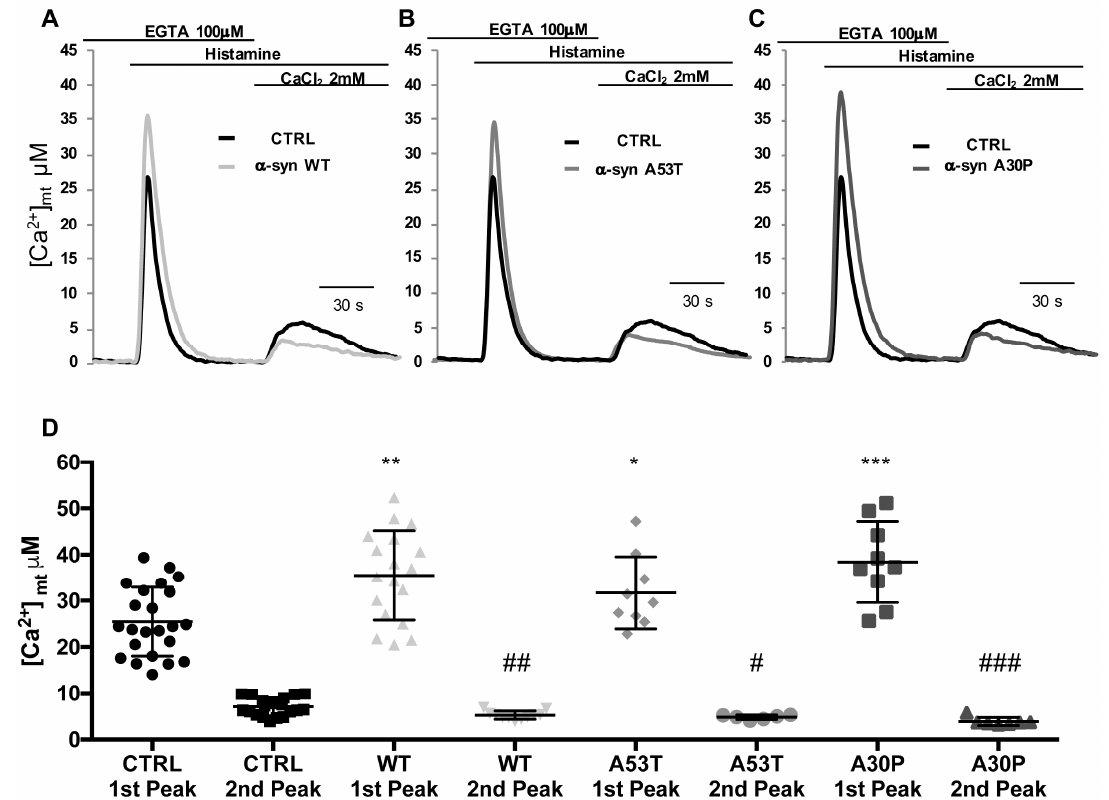
Figure 3. α -syn A53T and A30P mutants differently impinge on Ca 2+ transients generated by ER Ca 2+ release and Ca 2+ influx from the extracellular milieu. HeLa cells were co-transfected with mtAEQ and WT α -syn ( A ) or A53T ( B ) or A30P ( C ) α -syn constructs or transfected with mtAEQ only (control). To discriminate the contribution of Ca 2+ release from the ER and of Ca 2+ influx from the extracellular ambient to the generation of [Ca 2+ ] mt transients, HeLa cells were perfused in KRB/EGTA 100 μ M buffer and stimulated with histamine to release Ca 2+ from the intracellular stores (first peak). Then, the perfusion medium was switched to KRB/CaCl 2 2 mM (in the continuous presence of histamine) to stimulate Ca 2+ entry from the extracellular ambient (second peak). ( D ), Scatter plots represent mean [Ca 2+ ] peak values upon stimulation ± SD. * and # p < 0.05, ** p < 0.01, ## p < 0.005 *** p < 0.0005, ### p < 0.001. The results are the mean of at least three independent experiments. One-way ANOVA test retrieved a p -value of 0.0001. Unpaired Student’s two-tailed t -test was used for two-group comparison. No correction was applied since the same SD was assumed. Dunnet’s post-test was also applied to compare wt and α -syn mutants each other but no significance was detected. 1 st and 2 nd peak mean values were analyzed separately. The asterisks refer to Student’s two-tailed t -test where the comparison was for each independent sample vs. mock cells.